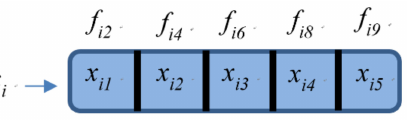
Figure 3. Structure of firefly